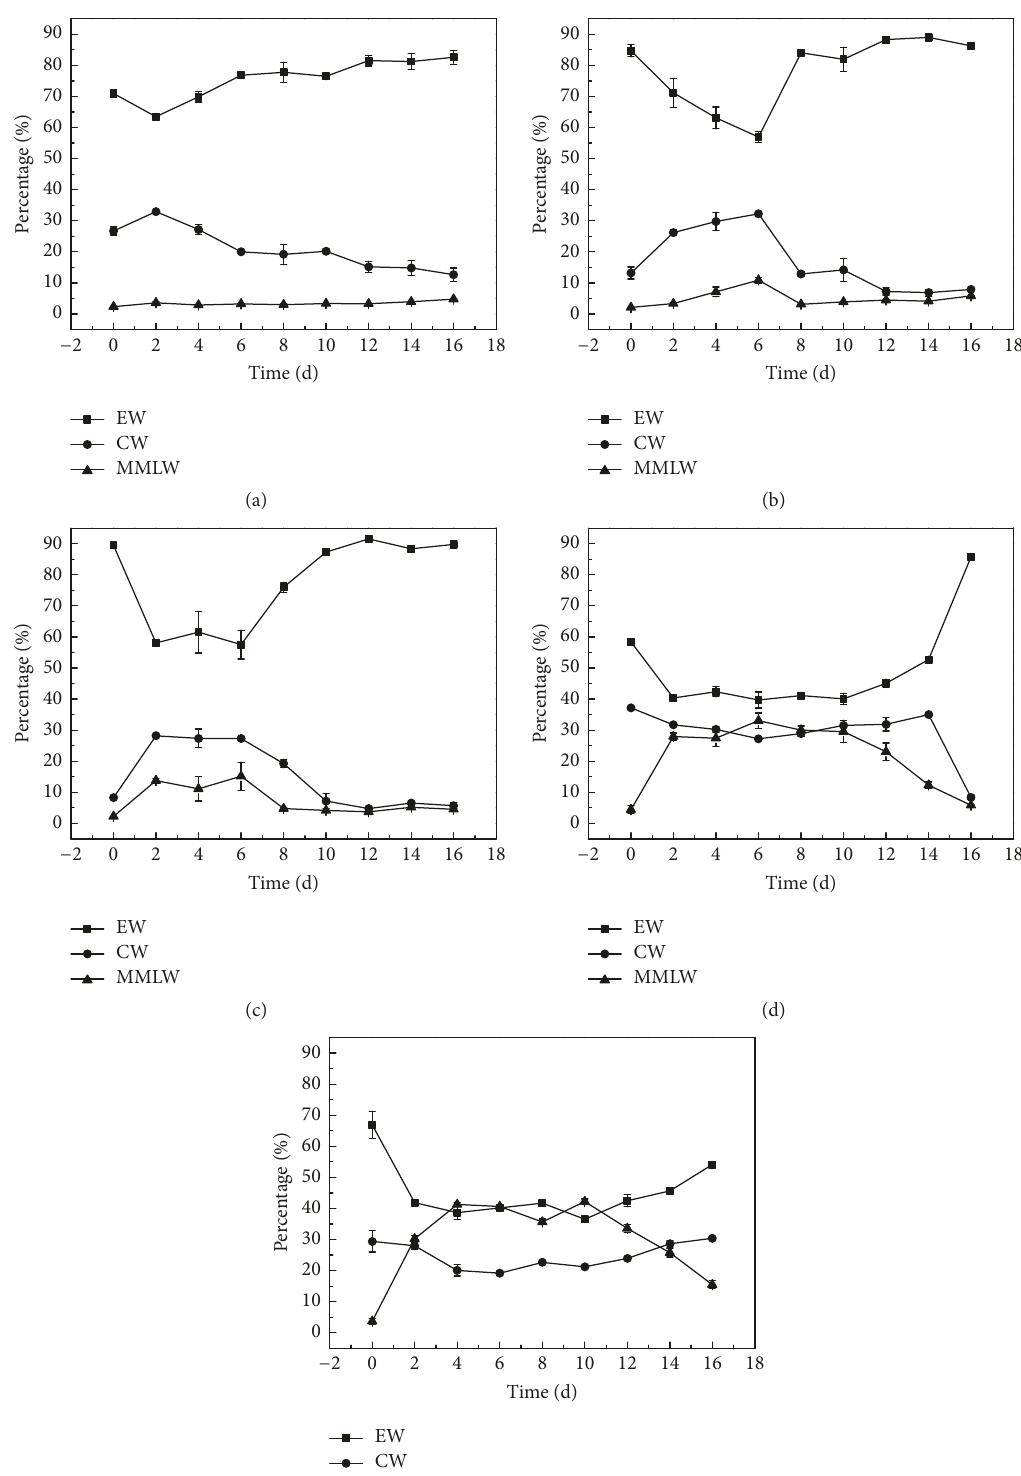
Figure 3: Variation of water states (EW, CW, and MMLW) during the composting process. (a), (b), (c), (d), and (e) represent R1, R2, R3, R4, and R5,